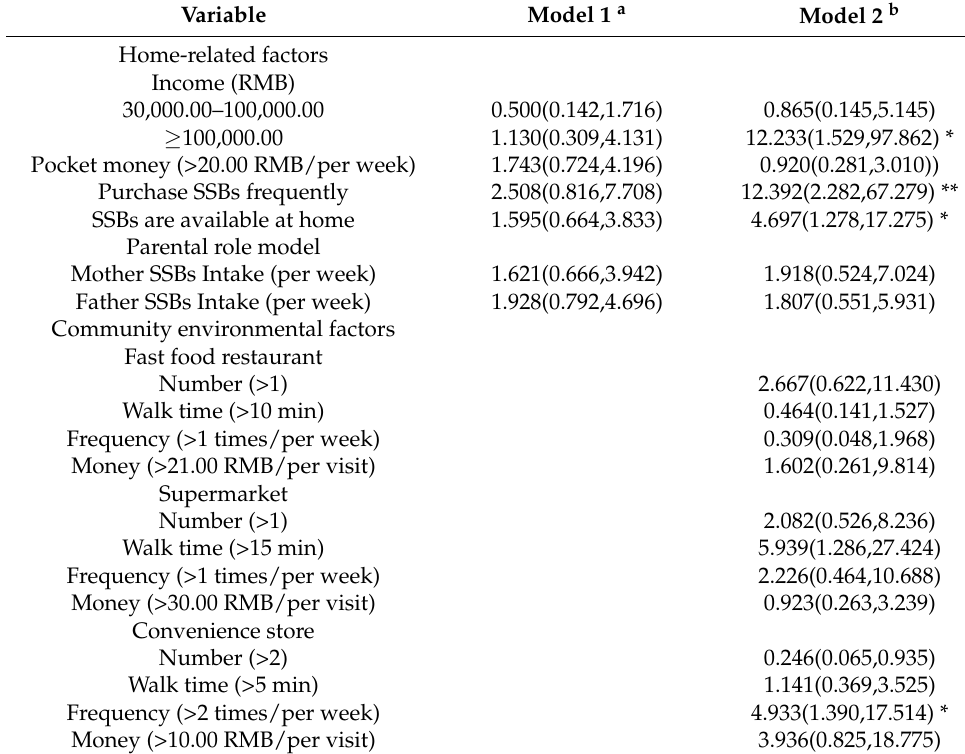
Table 7. Factors associated with beverages intake in overweight children.